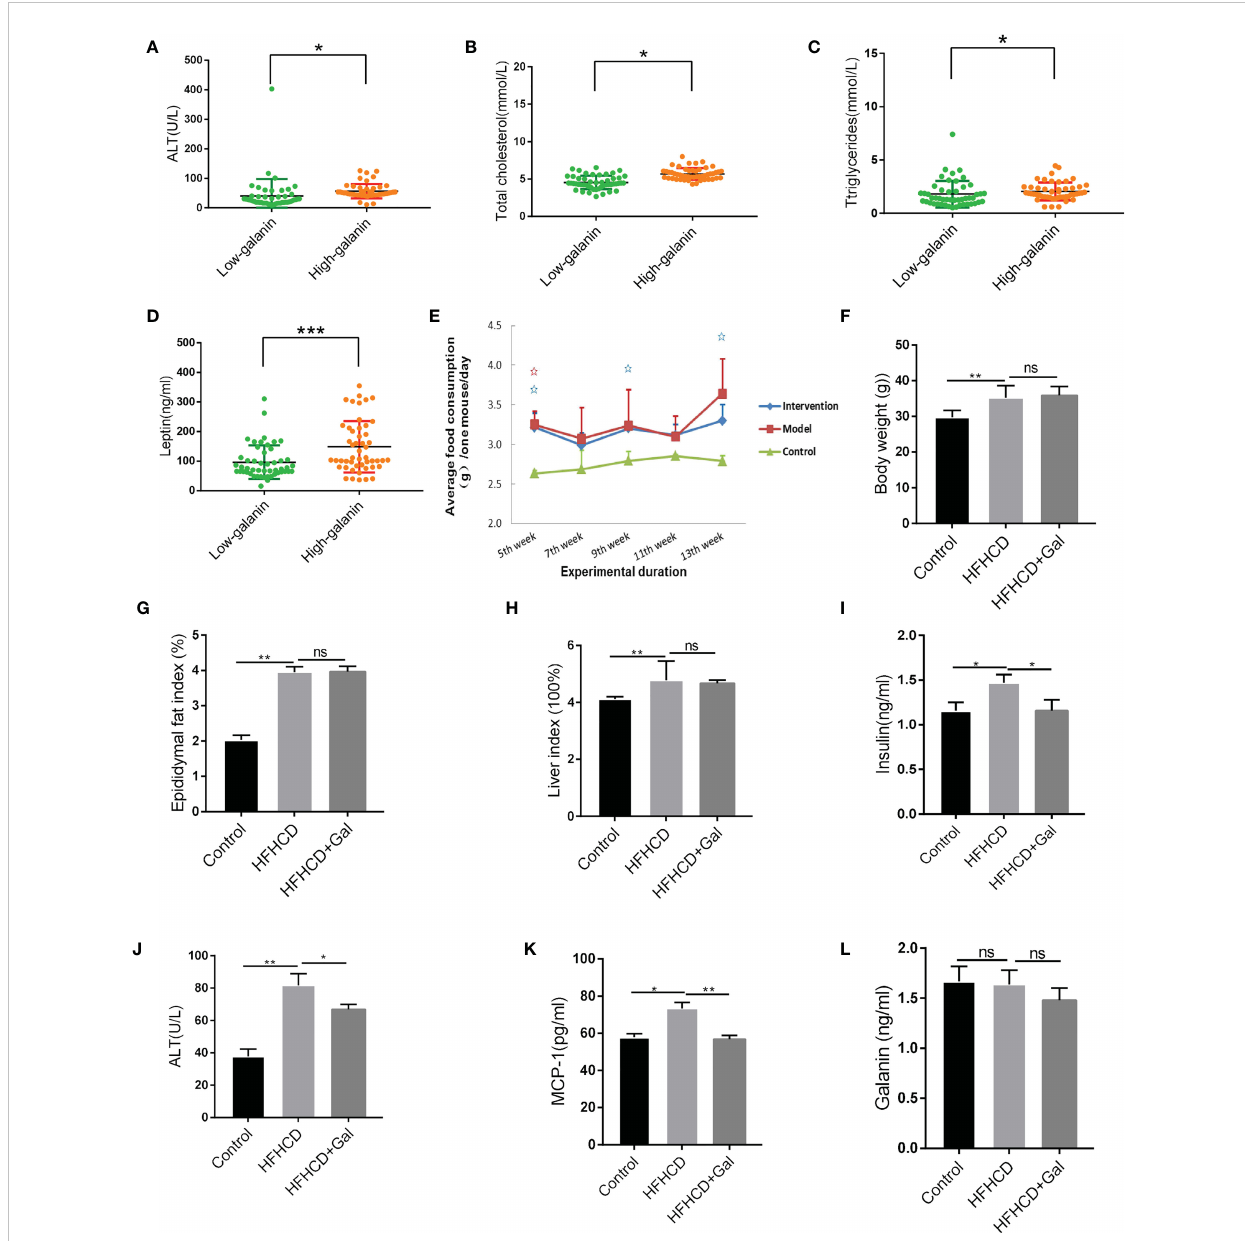
FIGURE 1 Galanin alters metabolism in HFHCD-fed mice. (A) Correlation analysis of ALT and galanin in human samples. *, p < 0.05. (B) Correlation analysis of total cholesterol and galanin in human samples. *, p < 0.05. (C) Correlation analysis of triglycerides and galanin in human samples. *, p < 0.05. (D) Correlation analysis of leptin and galanin in human samples. ***, p < 0.001. (E) The feed consumption of mice in each group. (F – H) The body weight (F) , epididymal fat index (epididymal fat weight g/weight g) (G) and liver index (liver weight g/weight g) (H) in HFHCD-fed mice. **, p < 0.01. (I – L) The serum insulin (I) , ALT (J) , MCP-1 (K) expression and serum galanin levels (L) in HFHCD-fed mice. *, p < 0.05, **, p < 0.01. ALT: Glutamic- pyruvic transaminase. MCP-1: Monocyte chemotactic protein